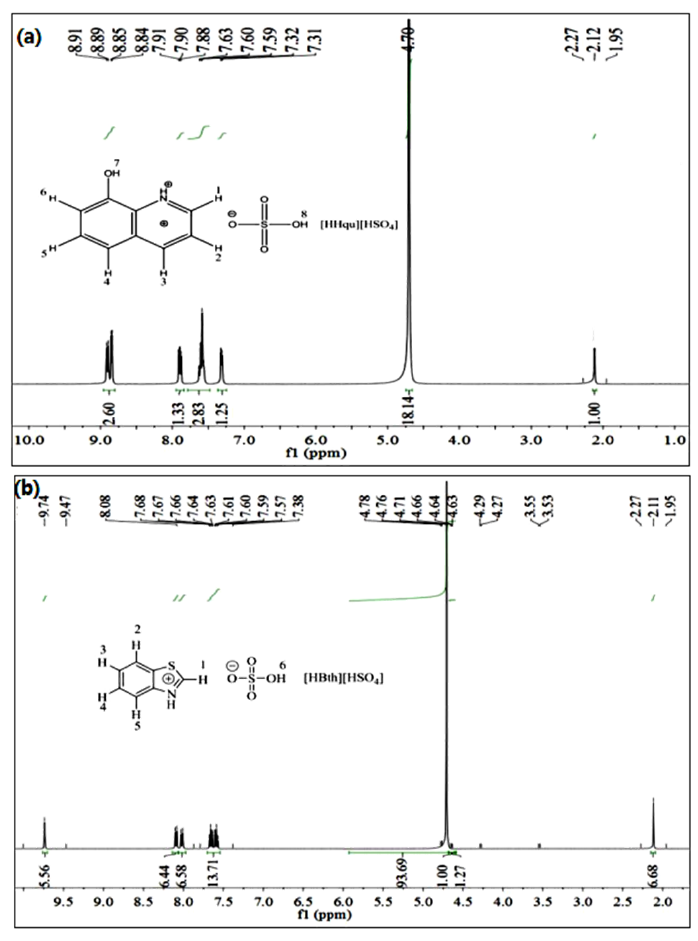
Figure 2. 1 H NMR of [HHqu][HSO 4 ] ( a ) and [HBth][HSO 4 ] ( b ) (500 MHz,